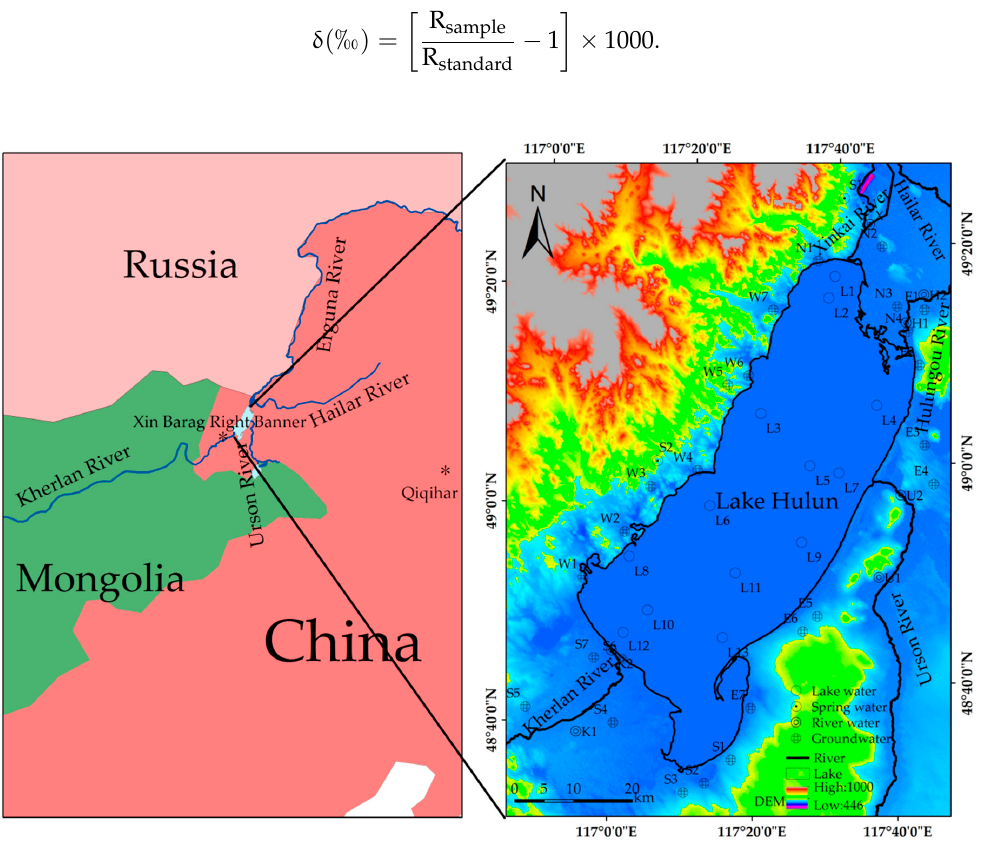
Figure 1. Map of sampling sites.